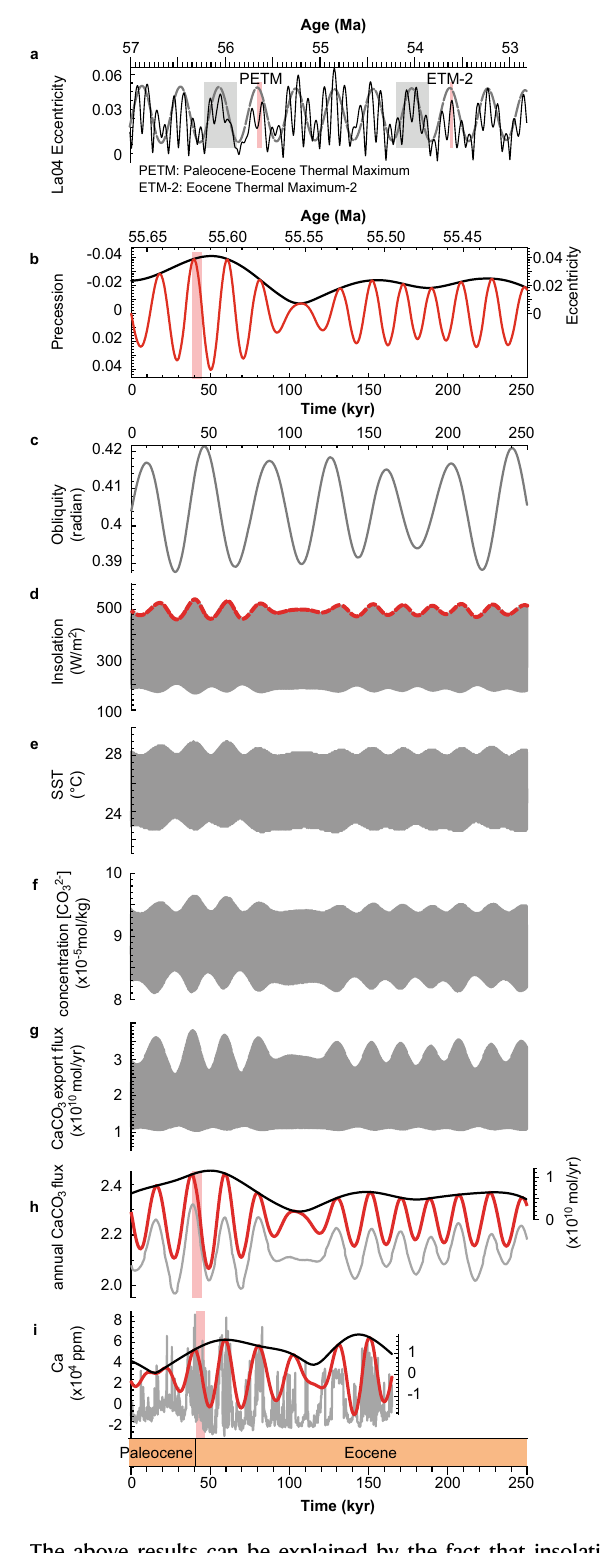
Fig. 6 | A model-data comparison of the Ca at Howards Tract. a Eccentricity of La2004 solution (black) 87 and fi ltered 405kyr cycles (dashed gray) 12 . Gray bars in a denote long-term eccentricity minima following 12 . b Eccentricity (black) and precession(red)modelsof La2004solutionfrom 55.66Mato 55.41Ma. c Obliquity model of La2004 solution from 55.66Ma to 55.41Ma. d Daily insolation (gray) at Howards Tract (HT) cores. Mean insolation on June 21 (dashed red) is also shown. Thesamplingrateis1kyr. e Dailyseasurfacetemperature(SST)atHTcores. f Daily oceansurface[CO 3 2 − ] concentration atHTcores. g Dailysurface CaCO 3 export fl ux at HT cores. h Annual surface CaCO 3 export fl ux at HT cores (gray) shown with its Taner fi ltered output (red, cutoff frequency range: 0.032 – 0.068kyr − 1 ) and ampli- tude modulation (black) using Hilbert transform in Acycle. i Tuned Ca content (gray) derived from the HT cores shown with its fi ltered 20kyr cycles (red, Taner fi lter with a cutoff frequency of 0.032 – 0.068kyr − 1 ) and amplitude modulation (black).Pink barsdenote the Paleocene-EoceneThermalMaximum carbonisotope excursion (CIE) onset (left bar in a , b , h , and i ) and Eocene Thermal Maximum 2 (right bar in a ). The frequency of daily time-series sampling is every 964 model time-steps, i.e., 20.083 year. Abbreviations: PETM, Paleocene-Eocene Thermal Maximum; ETM2, Eocene Thermal Maximum